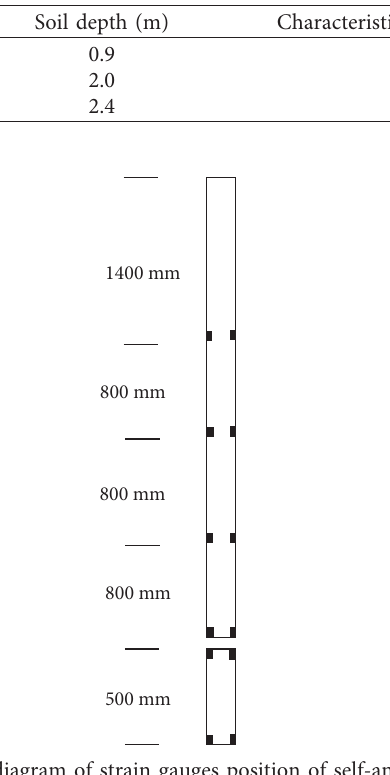
Table 1: Distribution of soil layer at test pile location.